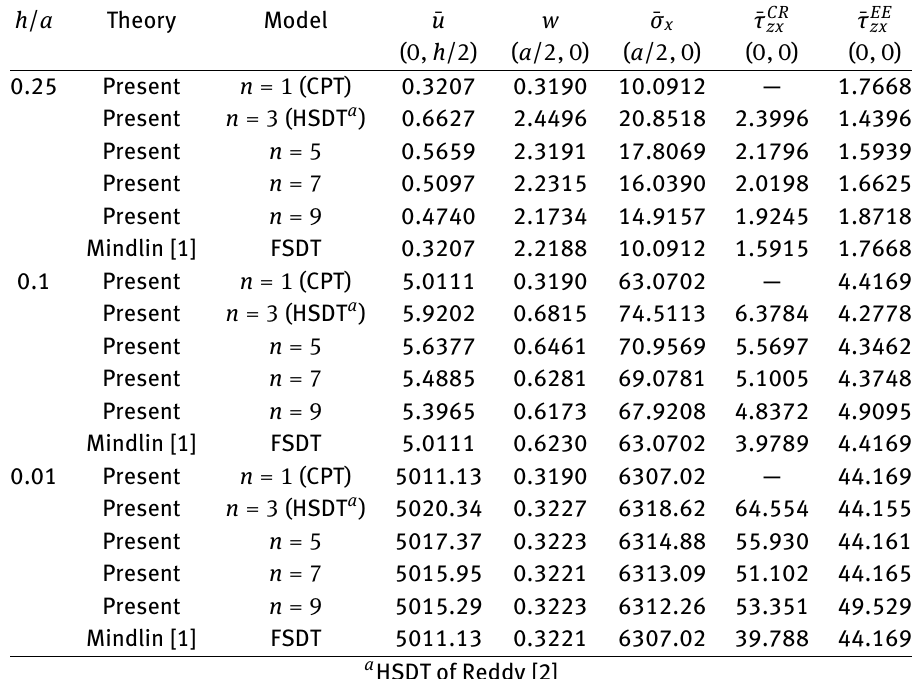
Table 4: Comparison of normalized displacements and stress for two layered (0 ∘ /90 ∘ /0 ∘ ) symmterically laminated composite plates in cylindrical bending (Material